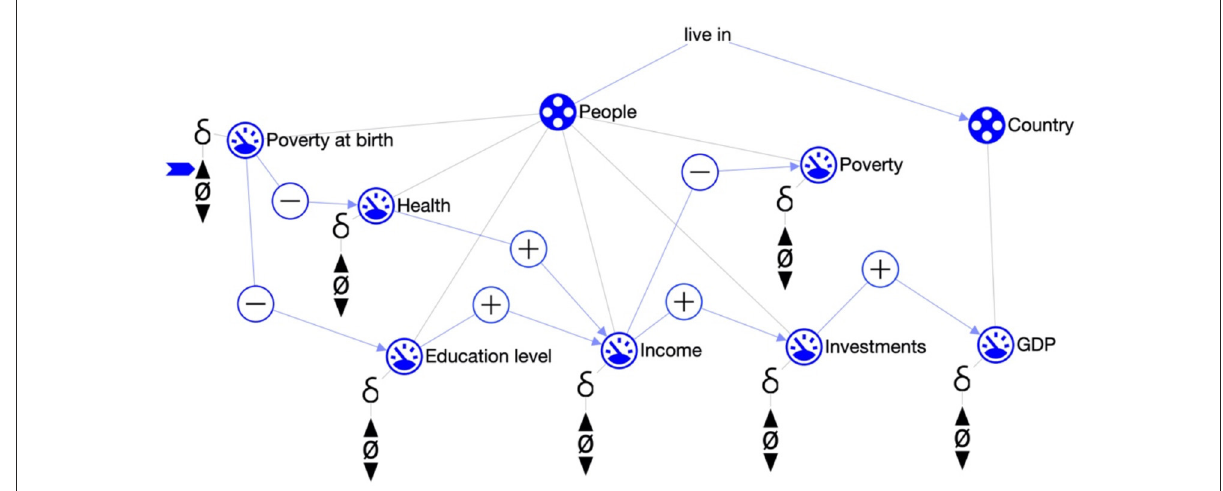
FIGURE2 Poverty (Spitz et al., 2021b). Entities are People and Country , whose relationship is live in . There are seven quantities , such as health and income . Quantities are related by positive ( + ) and negative (–) causal relationships. The direction of change is denoted by the δ . In this case, it is only specified for poverty at birth , which is set to be